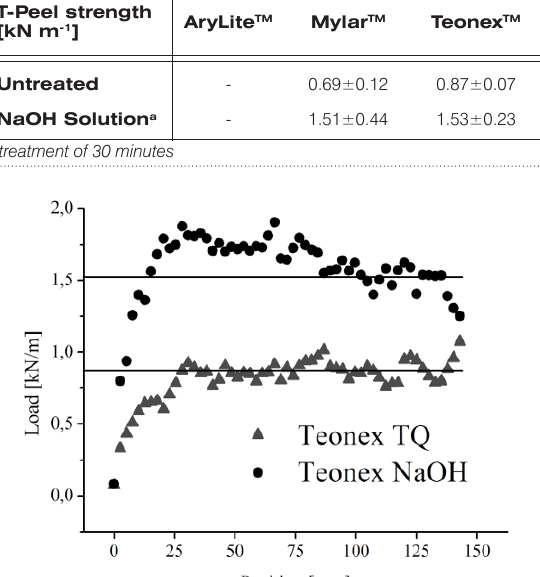
Figure 7. T-Peel test curve of Teonex TM sample.